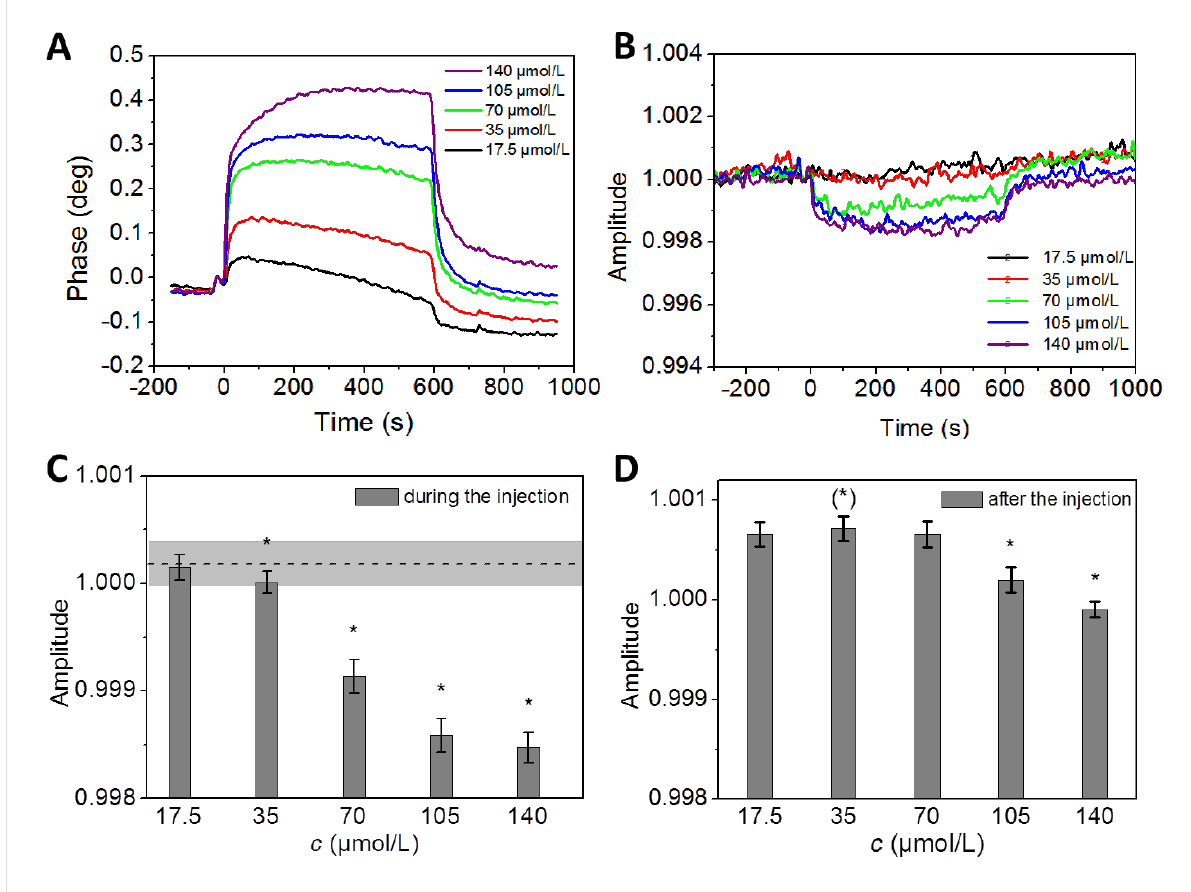
Figure 1: Phase and amplitude signal of microfluidic experiments on COO-SAM with calcium carbonate in pure water at different concentrations. Calcium carbonate solutions of 140 µmol/L (equilibrium saturation level, violet), 105 µmol/L (blue), 70 µmol/L (green), 35 µmol/L (red), 17.5 µmol/L (black) were injected in a sam ® X system and interactions with a COO-SAM sensor chip were monitored in real-time. The phase vs -time plot visual- izes the change of the phase signals (A) and the corresponding amplitude signals (B) of the sensor during the injection of the calcium carbonate solu- tions (0–600 s) and pure water (600–1000 s). (C), Statistical evaluation of averaged amplitudes prior to (shaded box) and during injections as shown in (B). (D), Comparison between the amplitude signals after the injections as shown in (B). There is a significant difference between the lowest concentration ( c = 17.5 µmol/L) and c = 105 µmol/L or, c = 140 µmol/L, indicating that long-lasting residence of calcium carbonate at the carboxylate- SAM interface occurs at c > 70 µmol/L but far below the calculated equilibrium in solution. Note that the amplitude signal during the injections (C) remained unchanged only for the lowest concentration ( c = 17.5